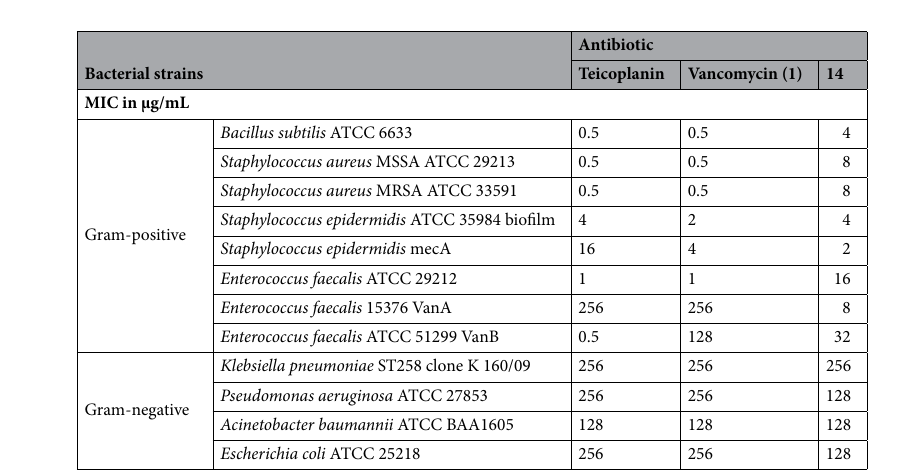
Figure 6. Atom numberings for compound 14 for NMR assignment.